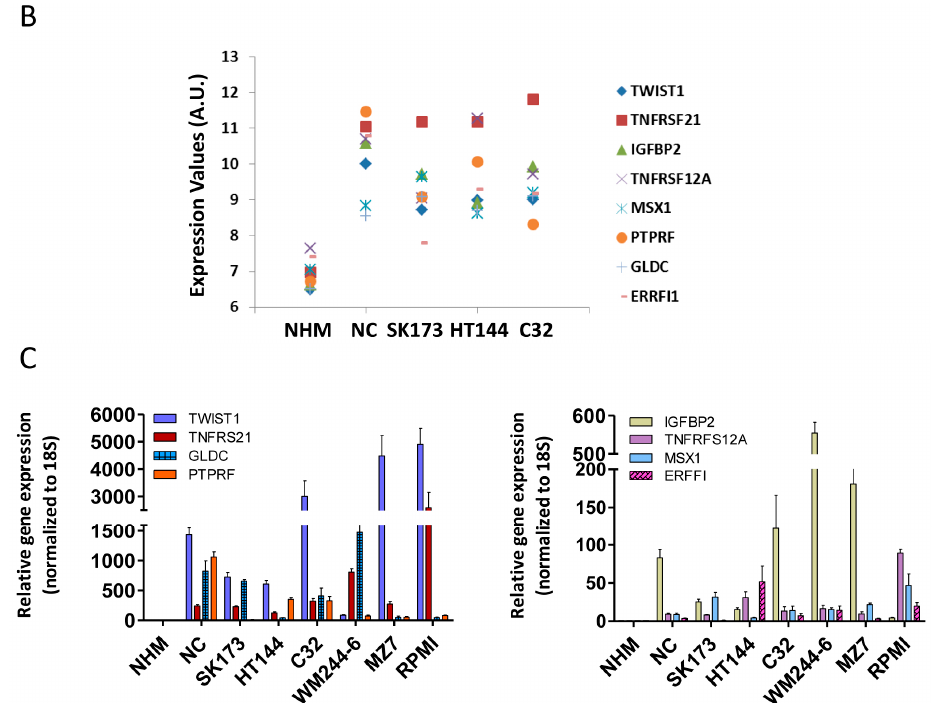
Figure 1. Detection of novel neural crest cell associated markers in melanoma cells. ( A ) Schematic of the workflow. Transcriptome of neural crest (NC) cells and melanoma cell lines were compared to either parental human induced Pluripotent Stem Cells (hiPSCs) or normal human melanocytes (NHM). The 8 most upregulated genes in both conditions were selected. ( B ) Gene expression values of the 8 candidate markers from the transcriptome analysis in NC and melanoma cell lines compared to NHM. ( C ) qPCR-based gene expression of the 8 candidate markers in NC and melanoma cell lines compared to NHM. rRNA 18S was used as an endogenous expression control. Data are shown as mean ± SD of biological triplicates.